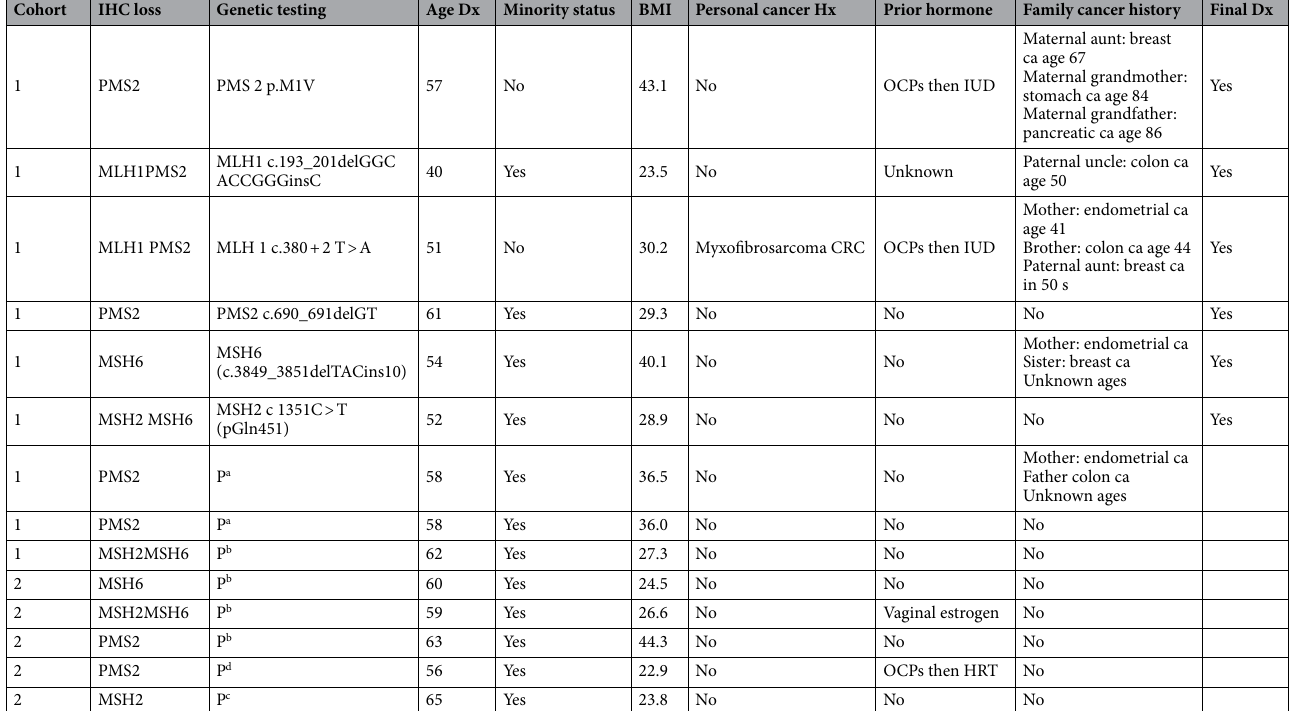
Table 4. Demographics and risk factors of suspected or diagnosed LS patients. a Referred to genetic counselor, then lost to follow up. b Referred to genetic counselor (did not go). c Lost to follow up. d No genetic testing performed to